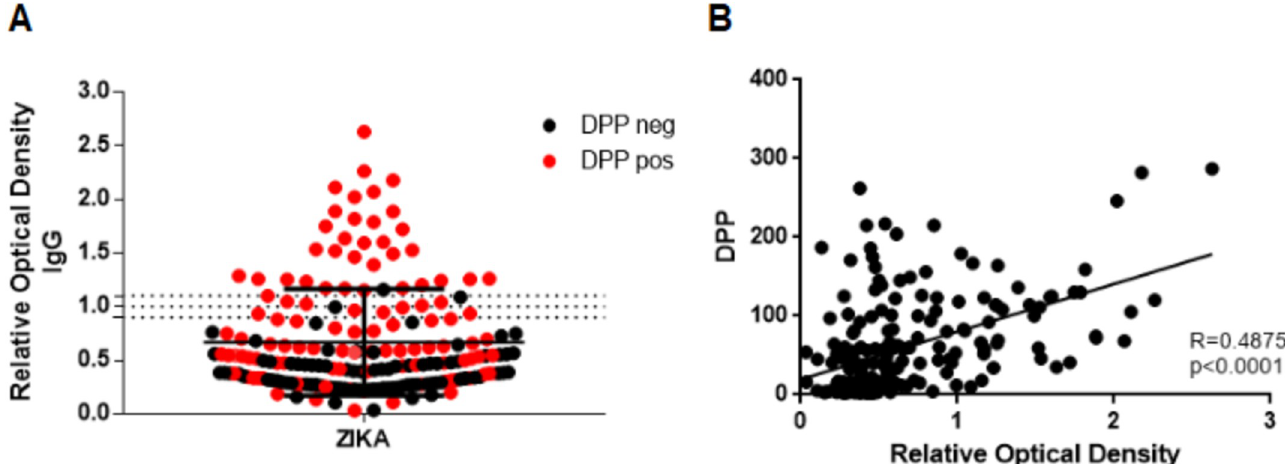
Fig 2. (A) Evaluation of the relative optical density of anti-NS1 Zika IgG for individuals with rapid IgG test negative (black) and positive (red). (B) Correlation between the Zika IgG rapid test result and the relative optical density of the Zika anti-NS1 IgG ELISA.